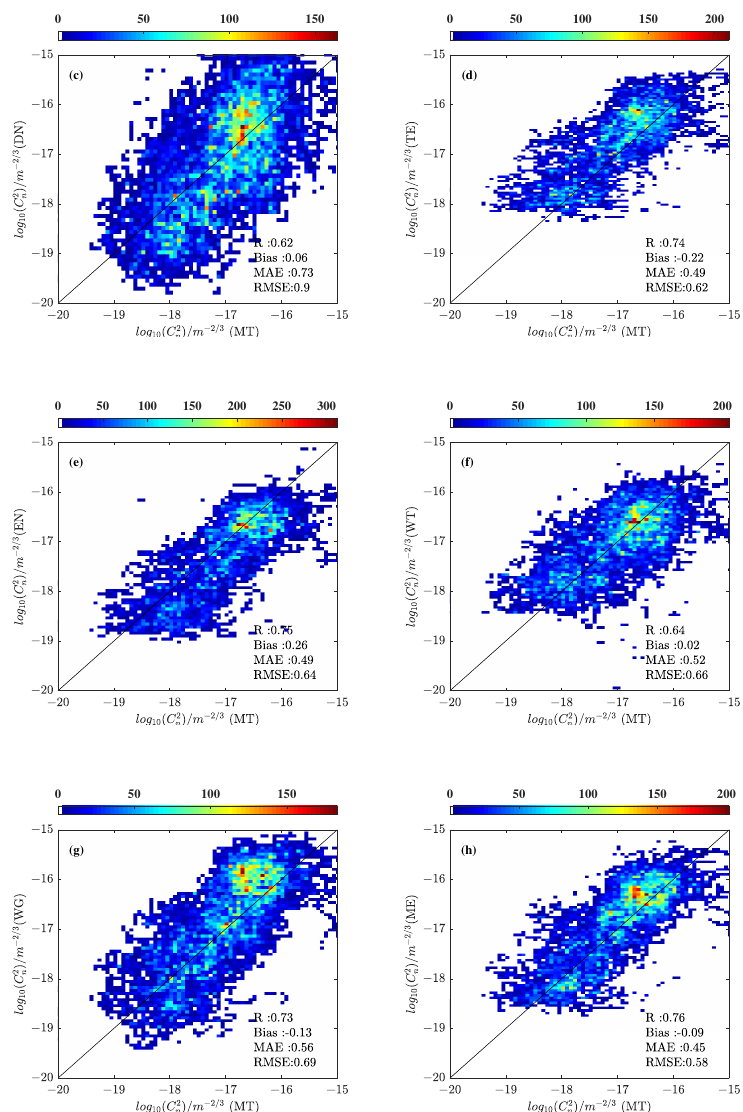
Figure 6. NCACN all launches MT vs. estimations C 2 n scatter diagram. ( a – h ) The same as Figure 4 but for